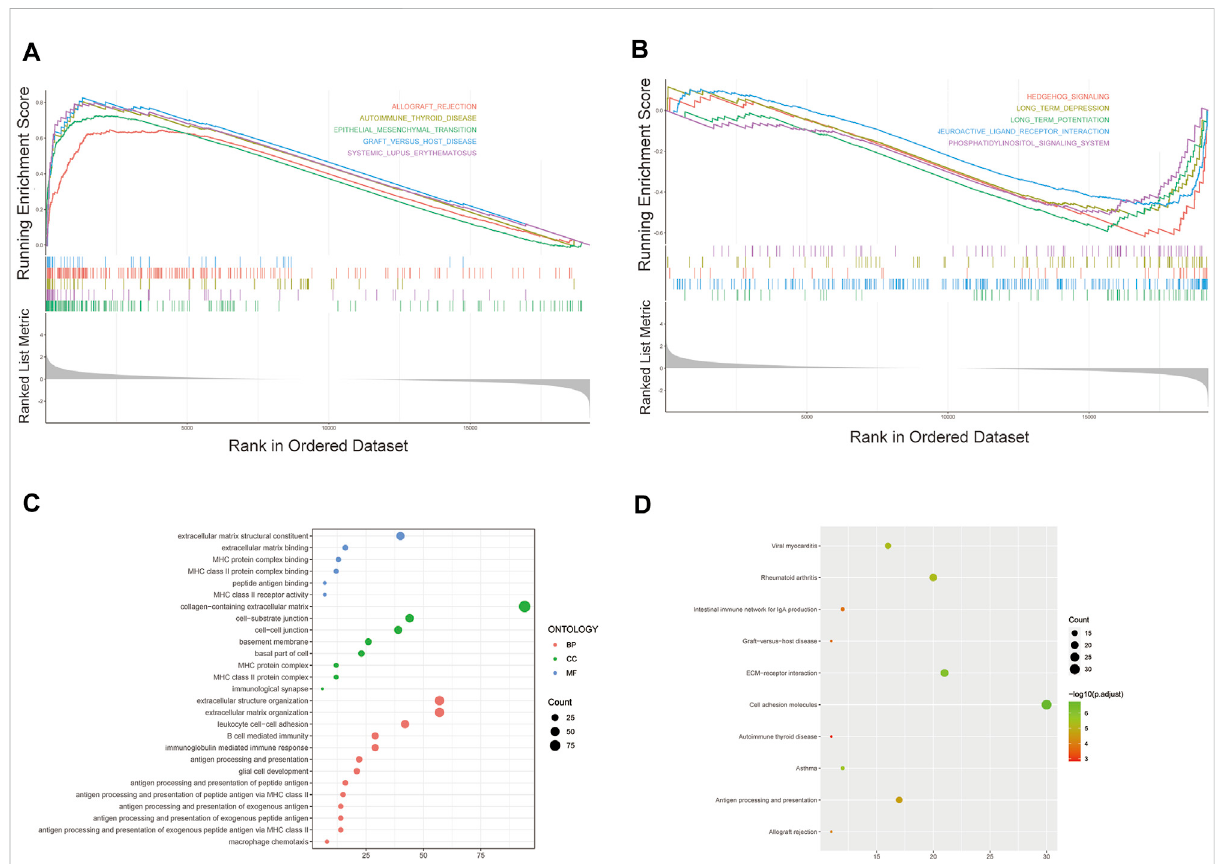
FIGURE 6 Gene biological function and pathway enrichment analysis of prognostic signatures of FRLs in high-risk group and low-risk group. (A) GSEA shows signi fi cant enrichment of immune-related and metastasis-related pathways in high-risk glioma patients. (B) GSEA shows signi fi cant enrichment of cancer-related signaling pathways in low-risk glioma patients. (C) GO analysis revealed enrichment of many immune-related processes and tumor metastasis-related processes. (D) KEGG analysis revealed that many immune-related processes and tumor metastasis- related processes were